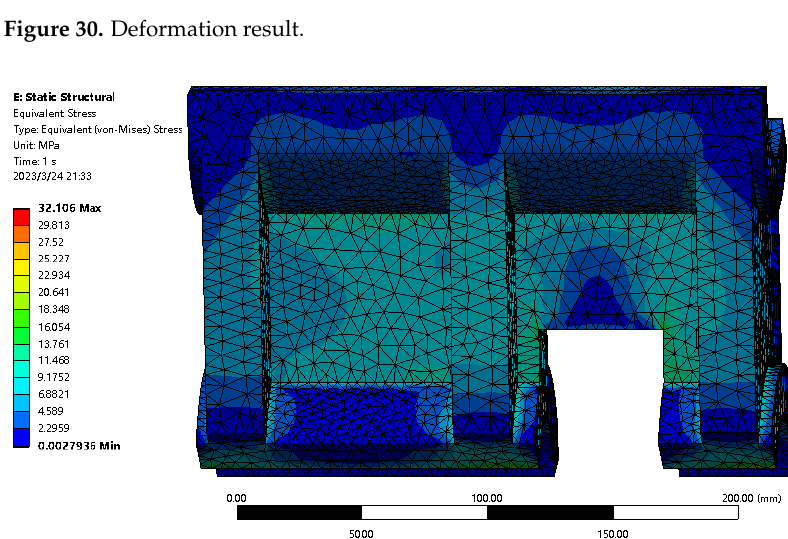
Figure 31. Stress distribution result.